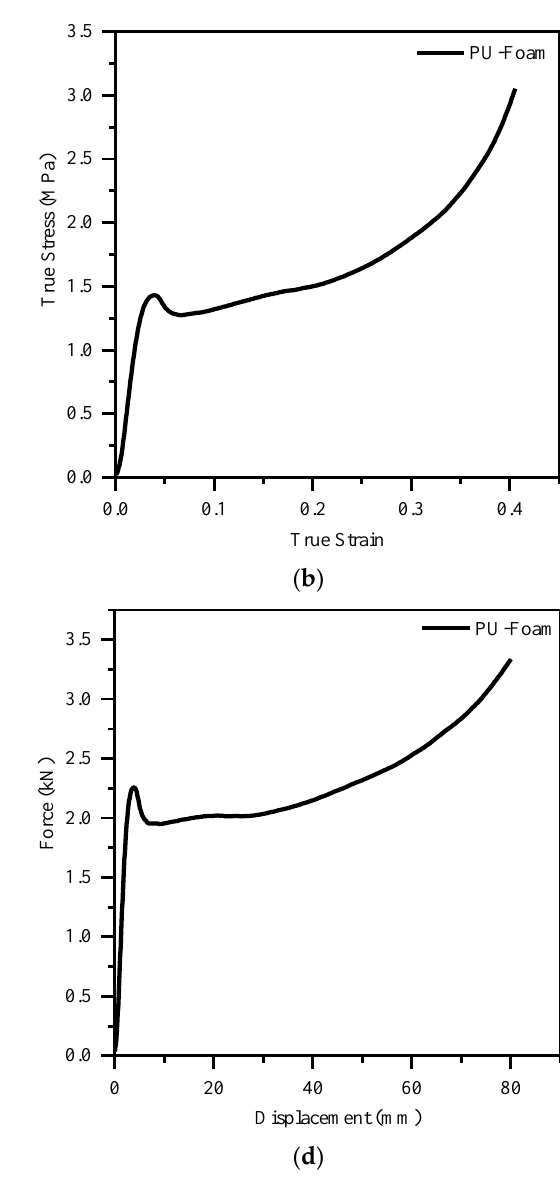
Figure 3. Experimental results of the material tests. ( a ) Stress–strain curve of AL; ( b ) stress–strain curve of PU foam; ( c ) stress–strain curve of CFRP; ( d ) force–displacement curve of PU foam under quasi-static compression.